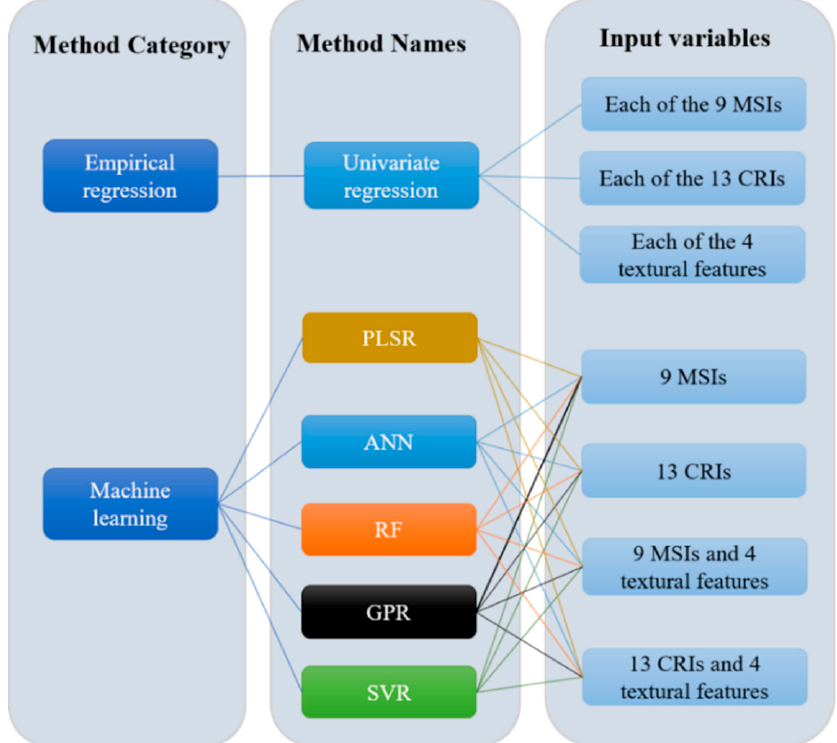
Figure 2. A flow chart of methods used for estimating CRC from Sentinel-2